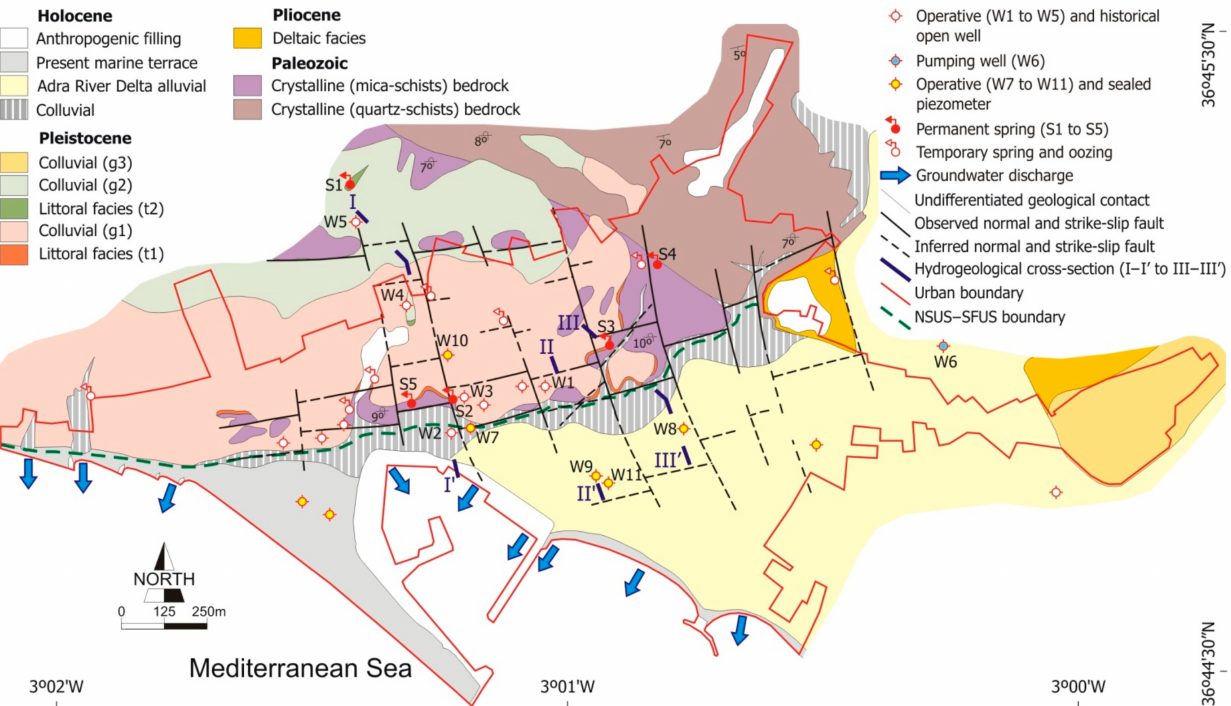
Figure 6. Hydrogeological map of Adra town at scale 1:5000, showing operative and historical groundwater observation points, sites where groundwater discharge to the sea is observable, and hydrogeological cross-sections I–I’, II–II’, and III–III’ as in Figure